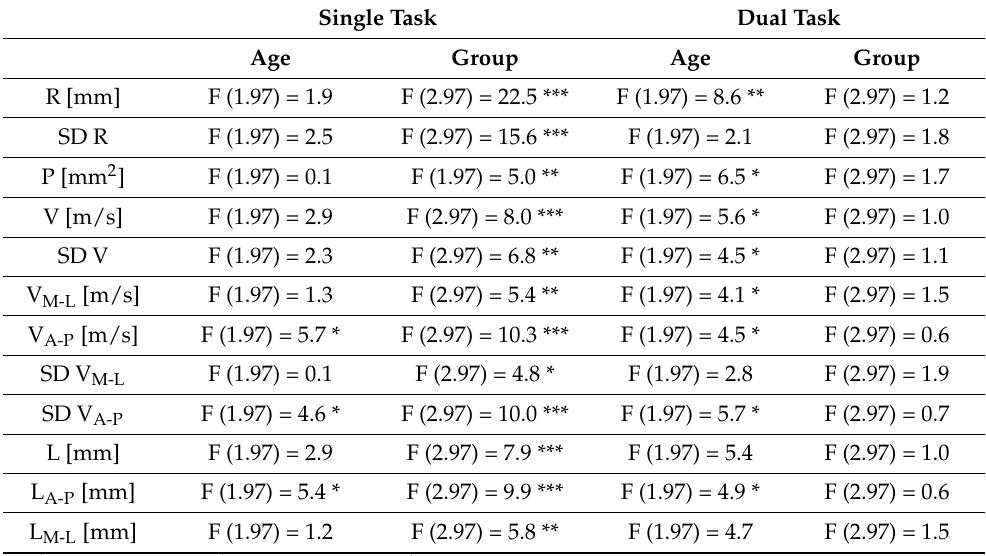
Table 2. Effect of age on stabilographic parameters during single and dual